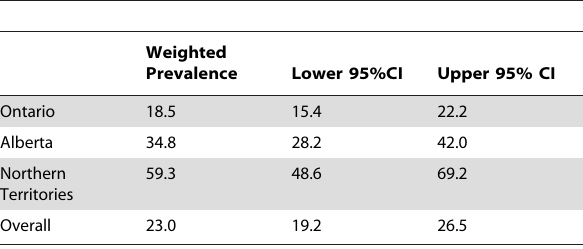
Table 1. Weighed prevalence (%) of smoking during pregnancy by Provinces and